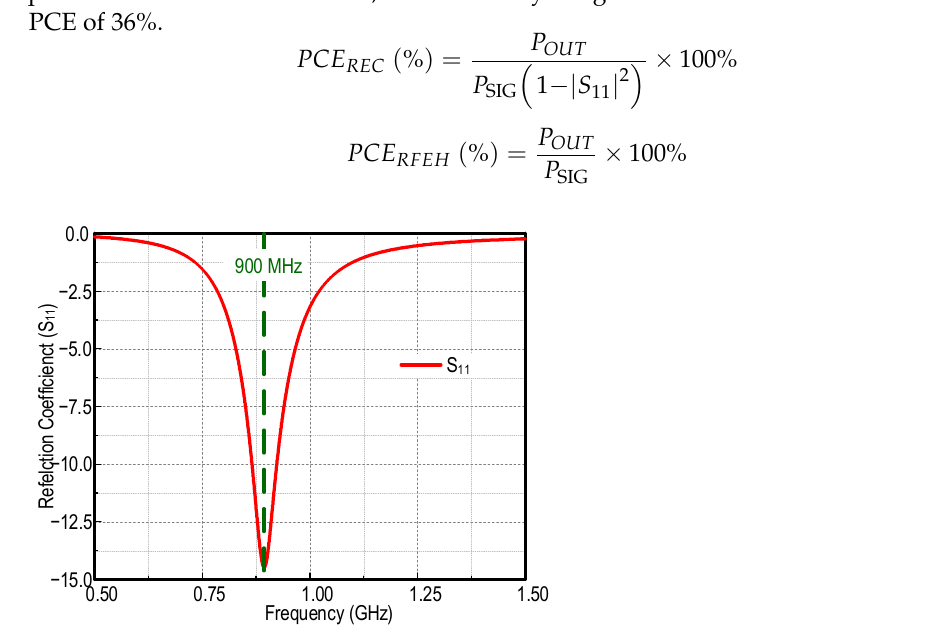
peak PCE of 88.7% at − 22 dBm, while the fully integrated RFEH front-end obtains a peak PCE of 36%.